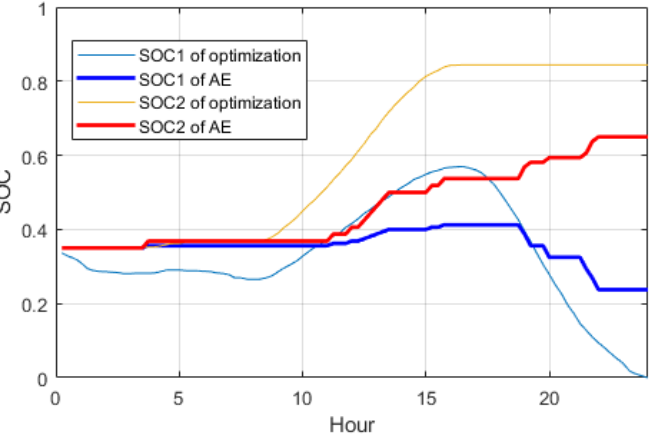
Figure 10. Conserveness reflection by SOC for AE and chance-constrained optimization.